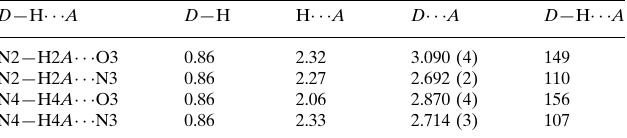
Hydrogen-bond geometry (A˚ , (cid:2)